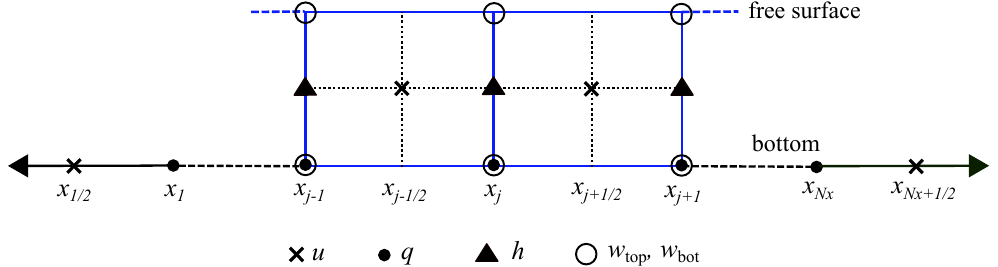
Figure 3. Staggered grid partition with locations of the unknown variables in the one-layer non- hydrostatic